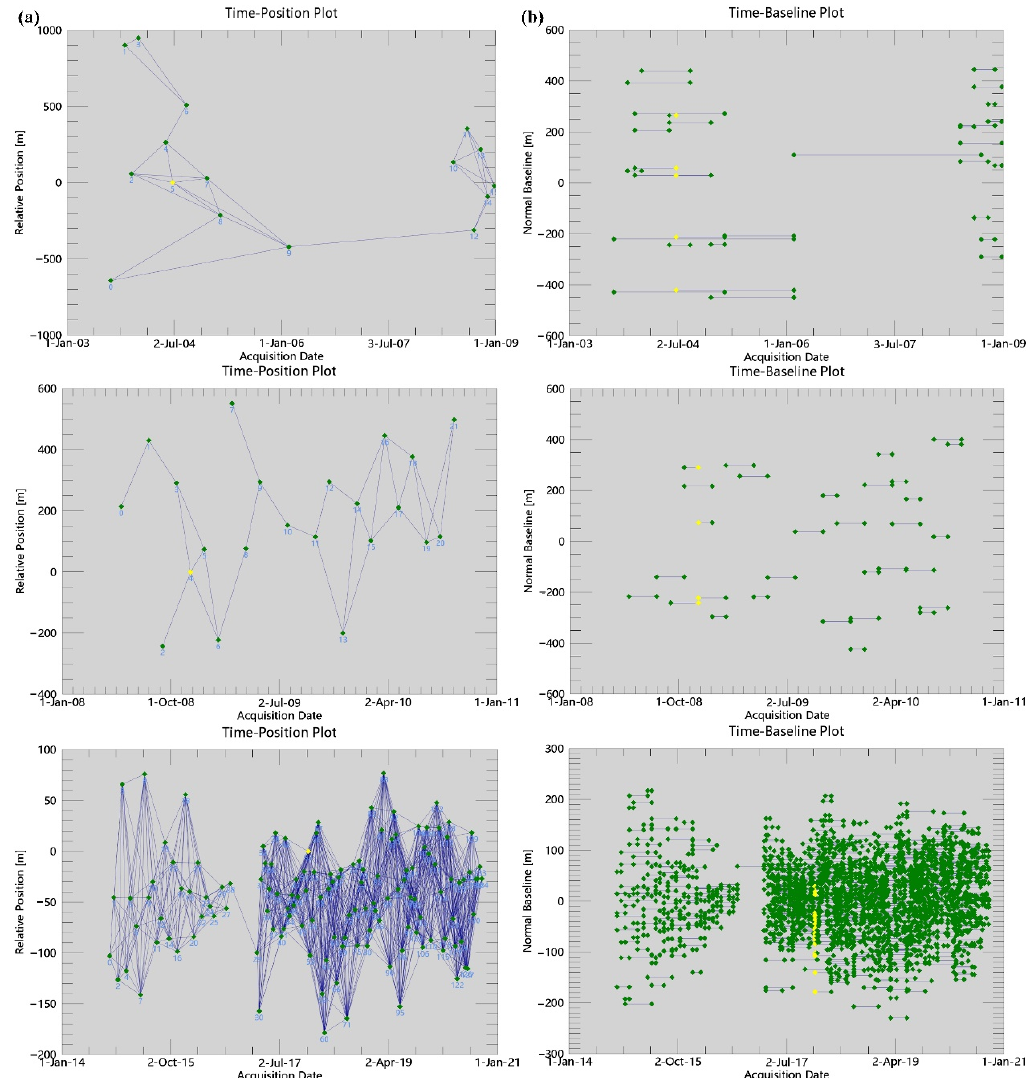
Figure 7. Spatial and temporal baseline of the SAR image interferogram. ( a ) Time–position of SAR image interferometric pairs; ( b ) time–baseline of SAR image interferometric pairs. (The yellow points denote the master image, the green points denote the slave images, and the blue lines represent interferometric pairs.)